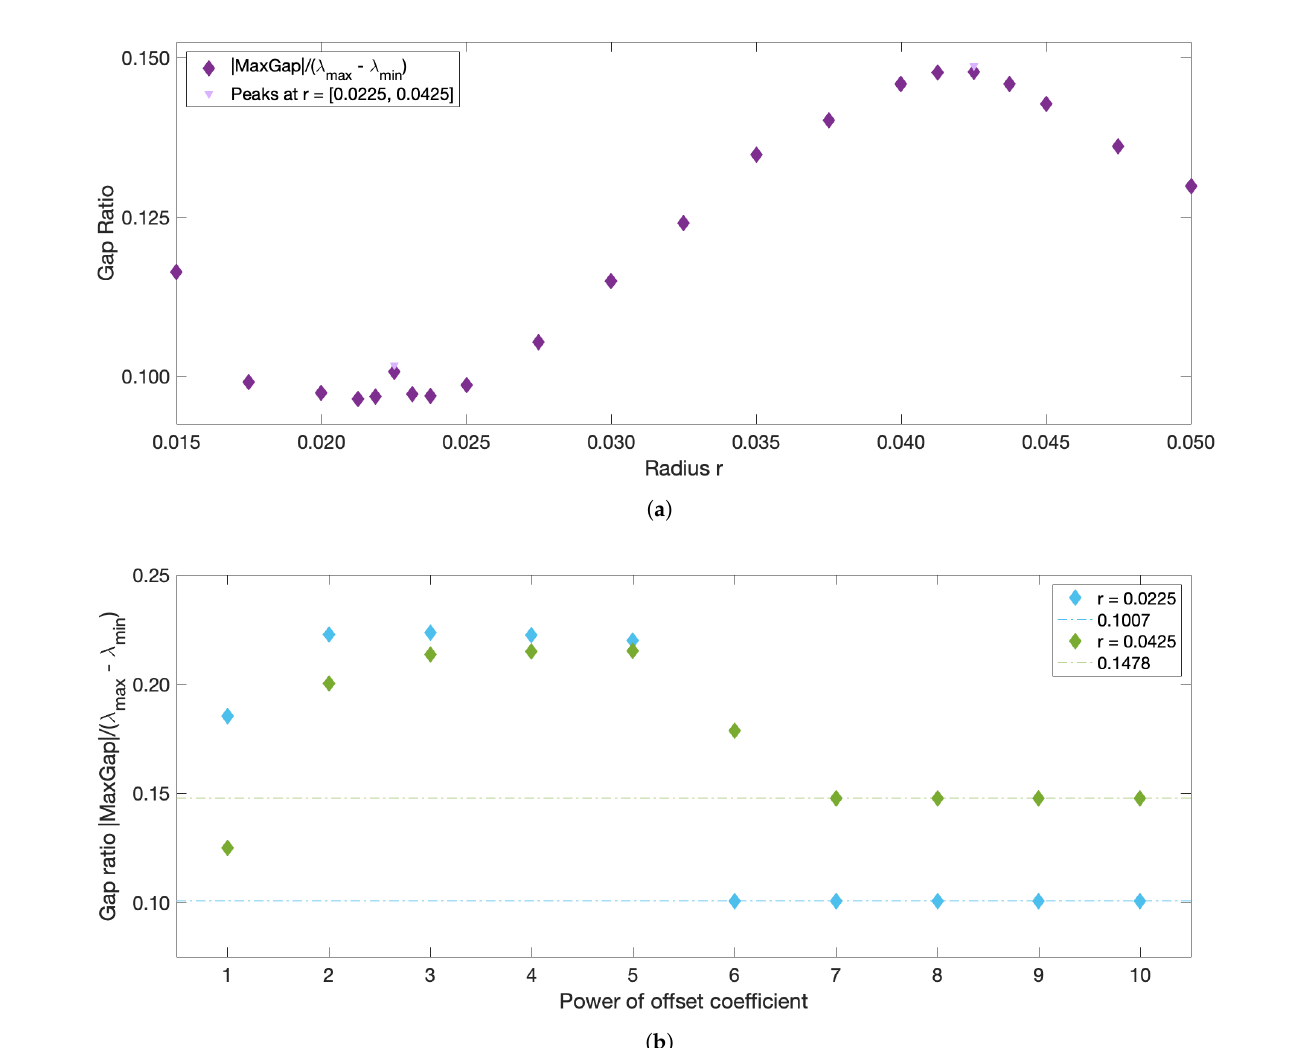
Figure A4. Steps 1 and 2 of the spectral clustering protocol for the 2018 No Man’s Land 16:00–22:00 experiment. ( a ) Sweep of r parameters with offset coefficient 10 7 for the average distance function. ( b ) Sweep of offset coefficients 10 n for average distance function and the normalized eigengap peaks from ( a